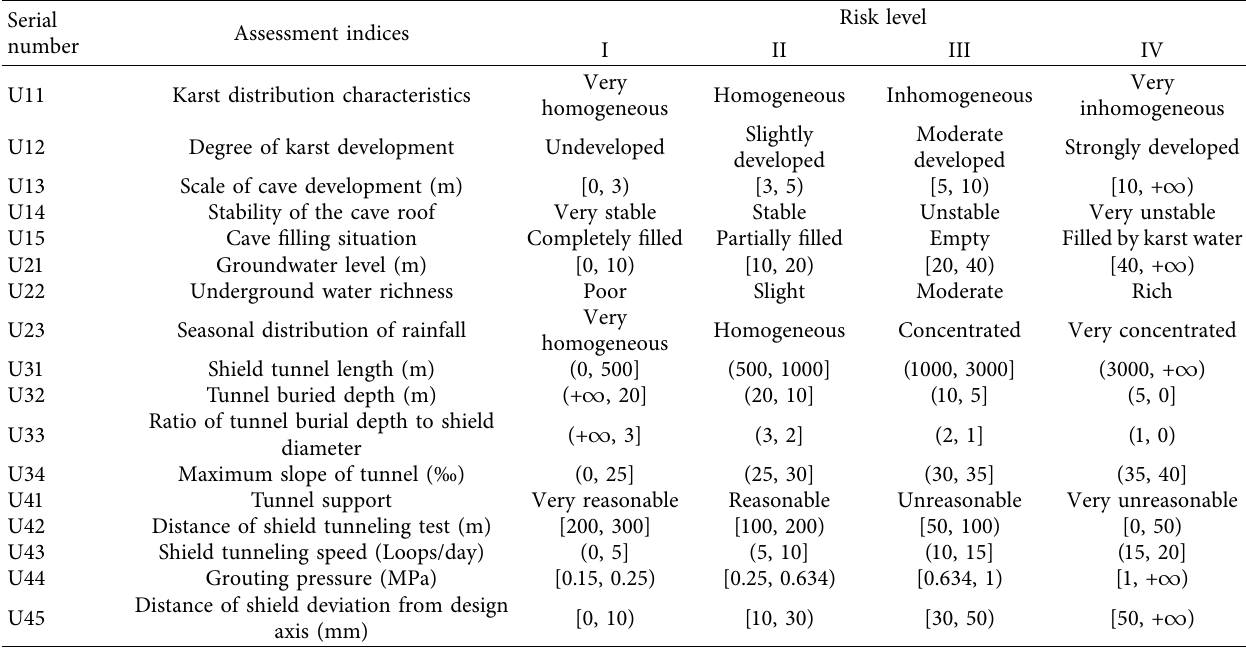
Table 3: Risk level classification criteria for evaluation